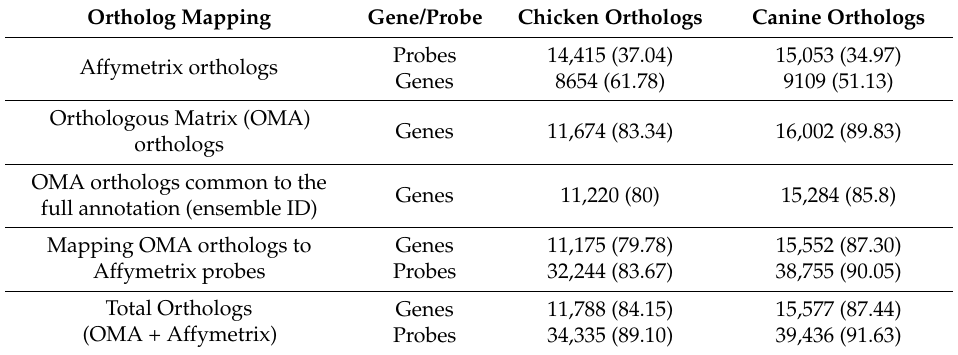
Table 2. Human ortholog mapping of Canis familiaris (Canine) and Gallus gallus (Chicken)